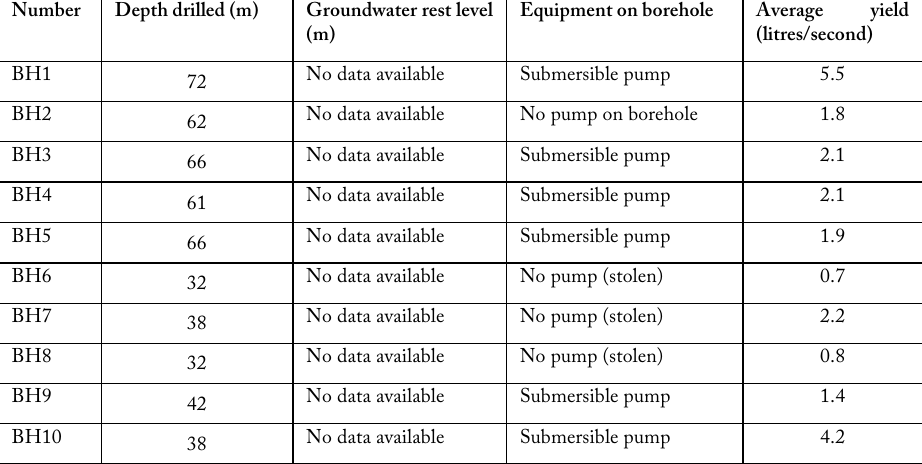
Table 1: Borehole information: Lindley (Labuschagne, 2012: Interview)